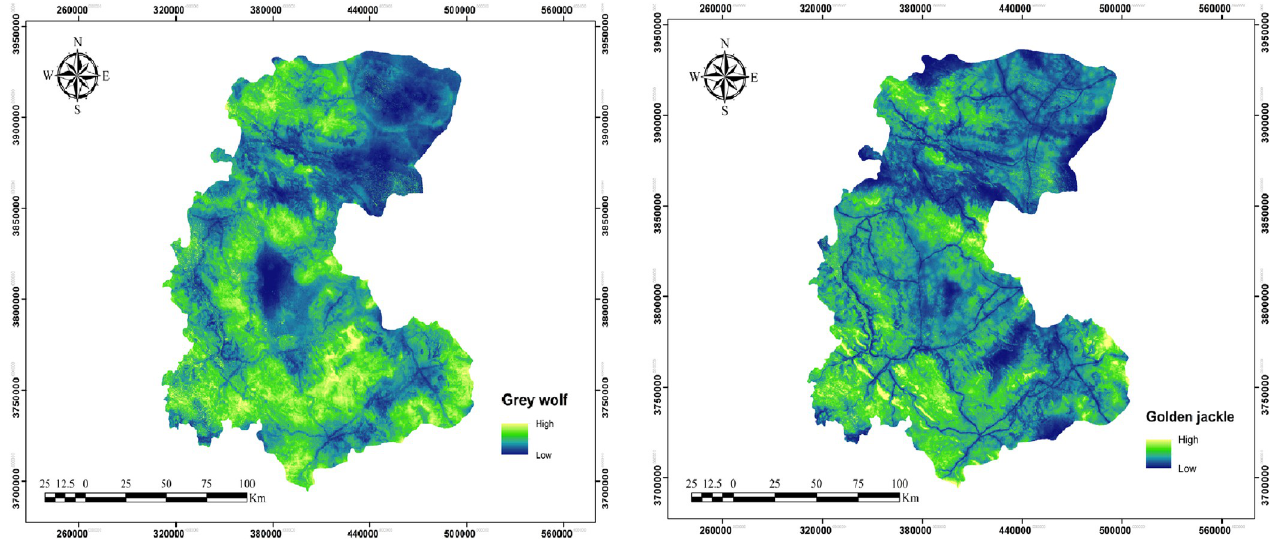
Fig 2. Predicted suitability of the study area for grey wolf and golden jackal based on the combined result of five SDMs. Republished from [http://www. frw.ir] under a CC BY license, with permission from [Forest, Range, Watershed Management Organization of Markazi province (IFRWO)], original copyright